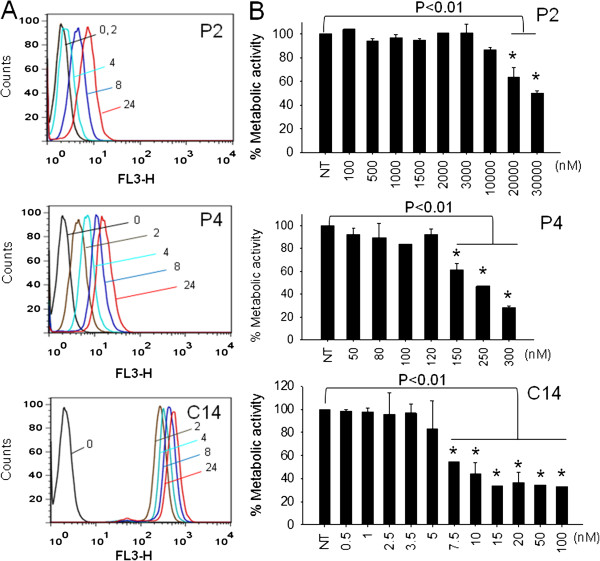
Uptake and metabolic activity of the cationic porphyrins. (A) FACS analyses of B78-H1 cells treated with 10 μM porphyrin. The fluorescence associated to the cells (Ex 420 nm, Em 650–720 nm), was detected at 2, 4, 8 and 24 h after drug delivery; (B) % Metabolic activity of B78-H1 cells treated with increasing amounts of porphyrin. 24 h after porphyrin delivery the cells have been irradiated with a halogen lamp at the fluence of 7.2 J/cm2. A resazurin assay was carried out 24 h after irradiation. Experiments have been performed in triplicate, a Student T-test is reported * = P < 0.01.